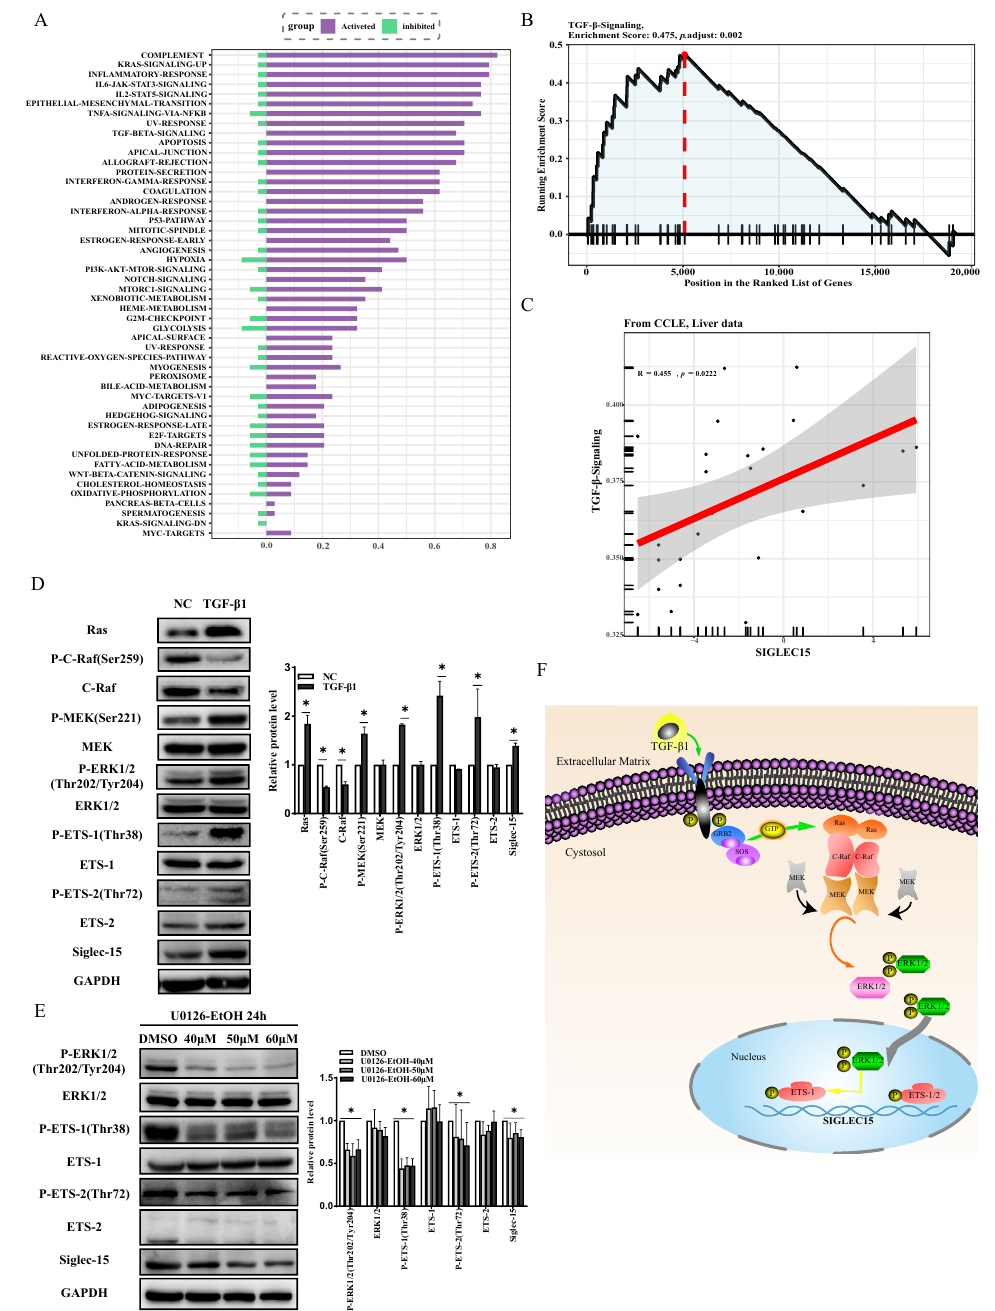
Figure 6. TGF- β 1 induces transcriptional activation of Siglec-15 via MAPK signaling pathway. ( A ) Enrichment analysis of signaling pathways associated with Siglec-15 using The Cancer Genome Atlas Liver Hepatocellular Carcinoma (TCGA-LIHC) dataset through GTBA platform. ( B , C ) The signaling pathway enrichment analysis ( B ) and correlation analysis ( C ) between Siglec-15 and TGF- β based on GTBA analysis using CCLE liver data source. ( D ) The expression levels of Ras/C- Raf/MEK/ERK1/2 signaling molecules, ETS-1/ETS-2 and their phosphorylation as well as Siglec-15 in HepG2 cells by Western blot analysis. ( E ) Effect of U0126-EtOH, a highly selective MEK1/2 inhibitor, on the expression of ERK1/2, ETS-1/2 and their phosphorylated forms as well as well Siglec-15 in HepG2 cells by Western blot analysis. ( F ) Schematic model for the mechanism by which TGF- β 1 activates Ras/C-Raf/MEK/ERK1/2 signaling to phosphorylate and activate ETS-1 and ETS-2 leading to upregulation of Siglec-15 expression. * p < 0.05. NC stands for untreated